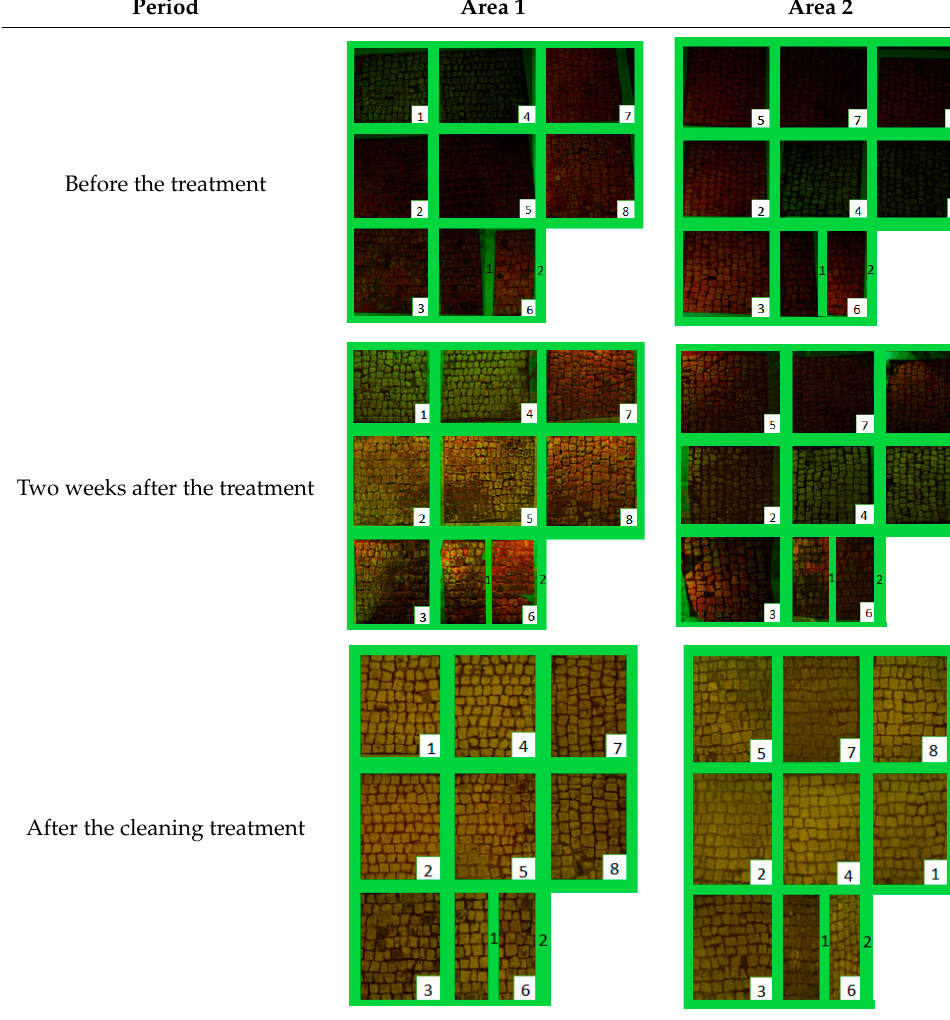
Table 5. UV images of Areas 1 and 2 before the biocide treatment, after two weeks from the appli- cations and after the cleaning procedure in UVL. Legend of the figures in the table: (1) Preventol ® RI50 (cleaned area), (2) Preventol ® RI50, (3) Essenzio, (4) SI-QUAT, (5) Bionature, (6_1) AUTEAB supported, (6_2) AUTEAB washed, (7) LIQ, and (8) Biotersus. Period Area 1 Area 2